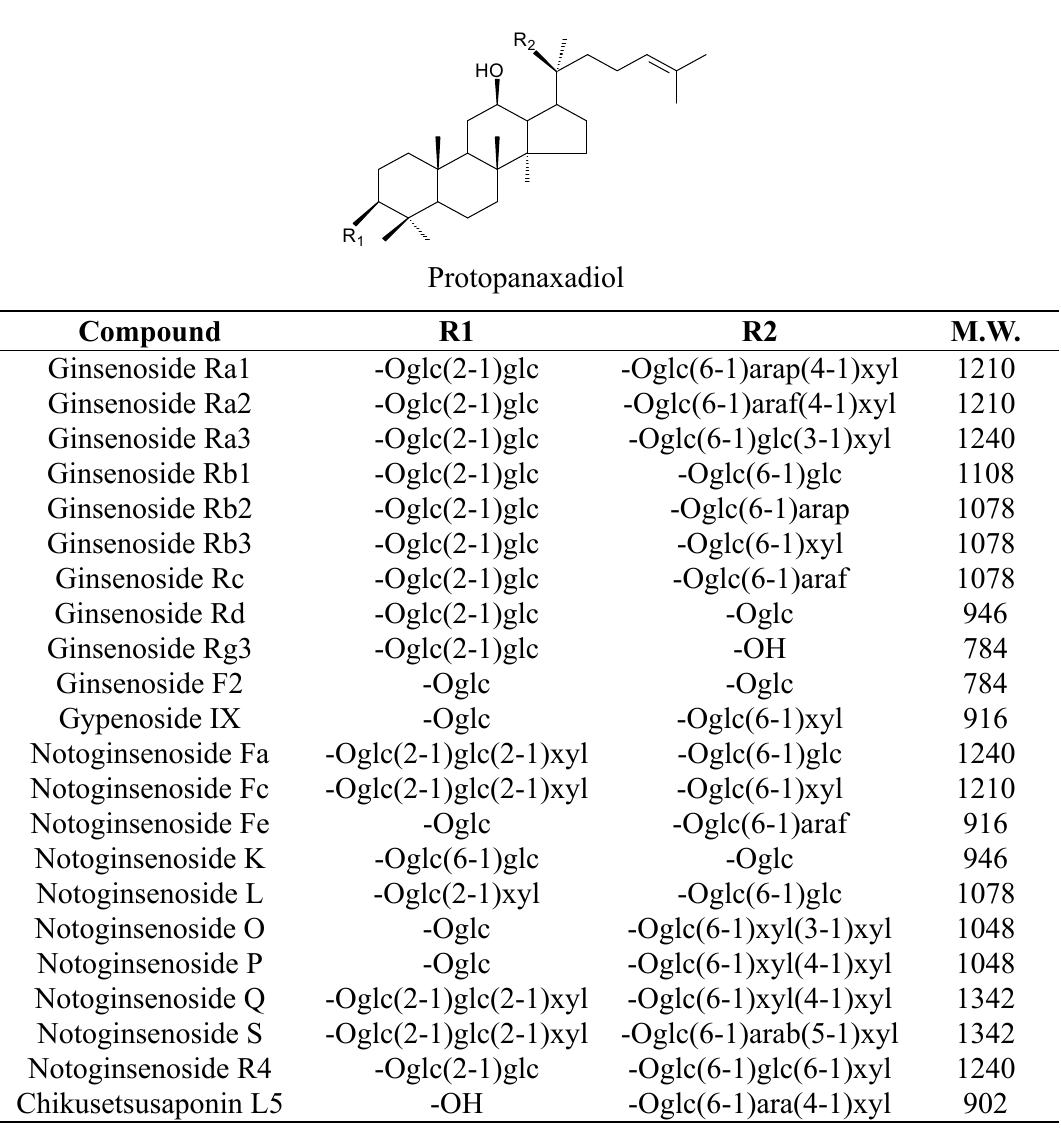
Figure 1. Chemical structures and molecular weight of saponins identified in different parts of P. notoginseng . Glc, β - D -glucopyranosyl; Rha, α - L -rhamnopyranosyl;